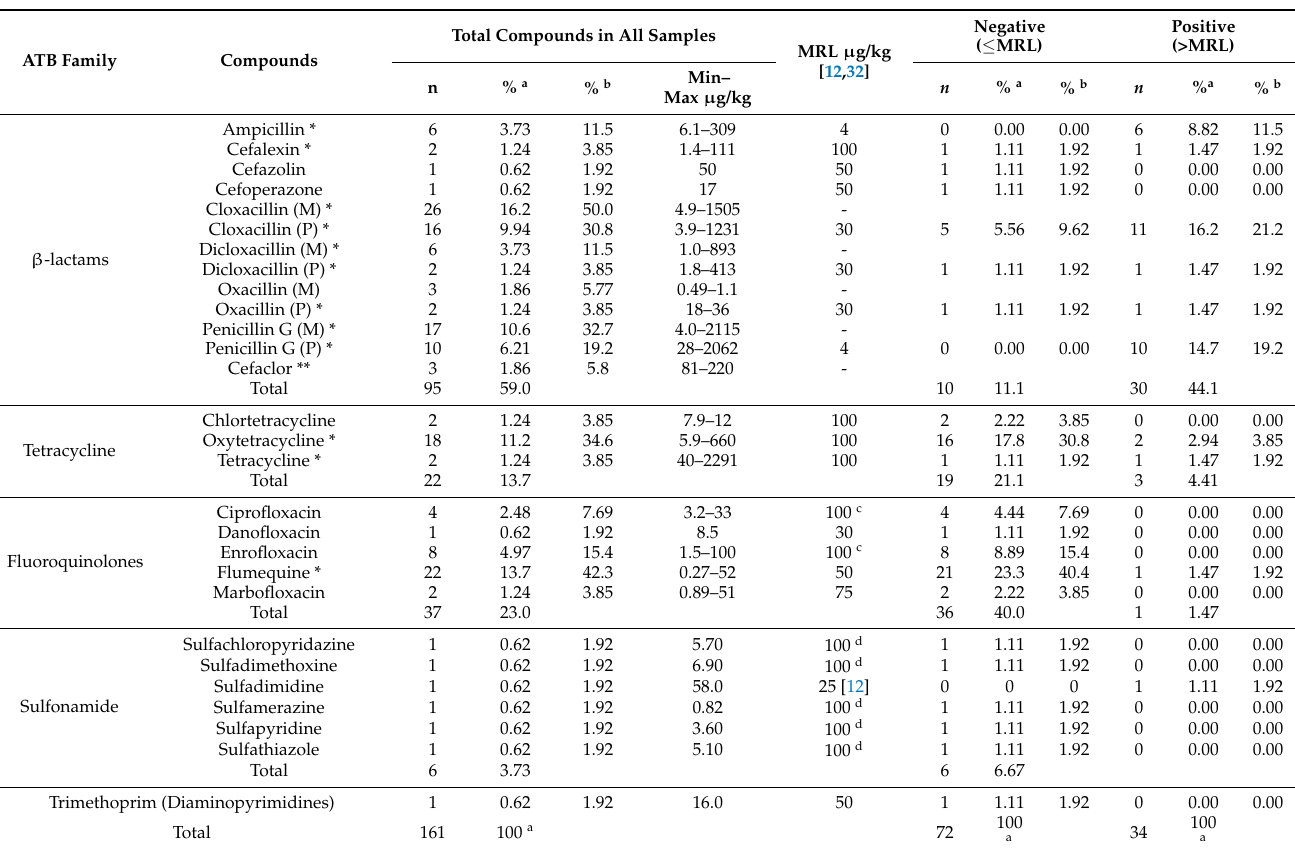
Table 3. Frequency of antimicrobial residues in milk assessed by LC-MS/MS in the studied dairy companies.